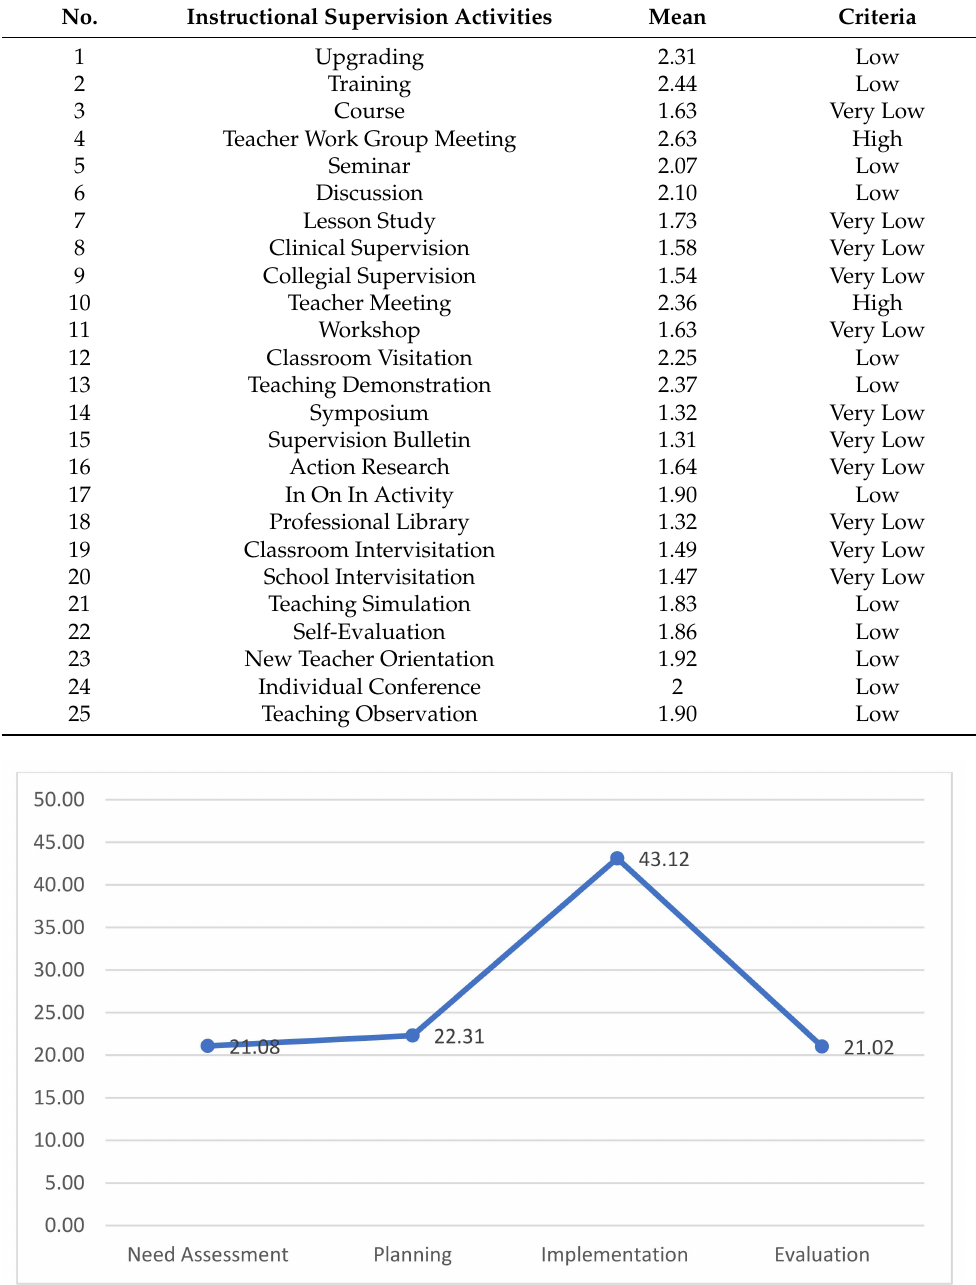
Table 1. Frequency of ICT use in instructional supervision activity programs.